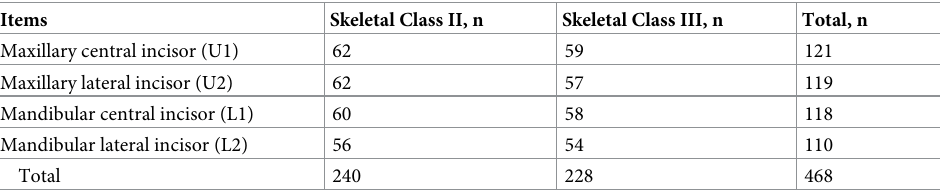
Table 2. Distribution of